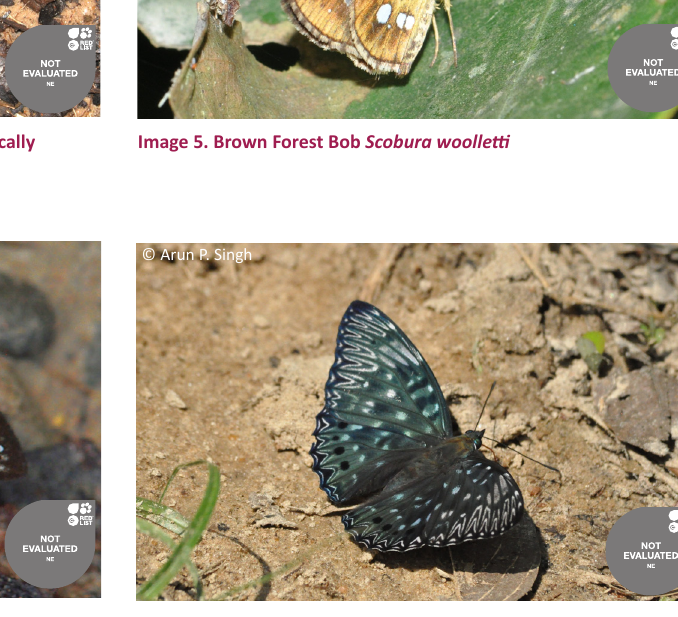
Image 6. Snowy Angle Darpa pteria dealbata Image 7. Constable Dichorragia nesimachus